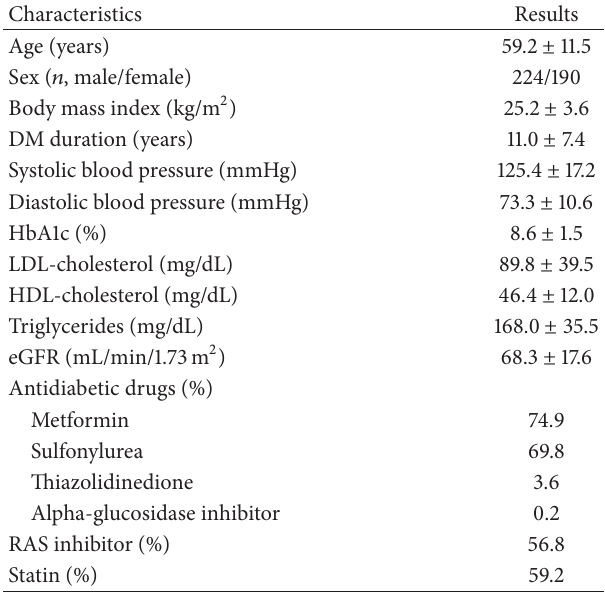
Table 1: Patient baseline characteristics ( 𝑁 = 414